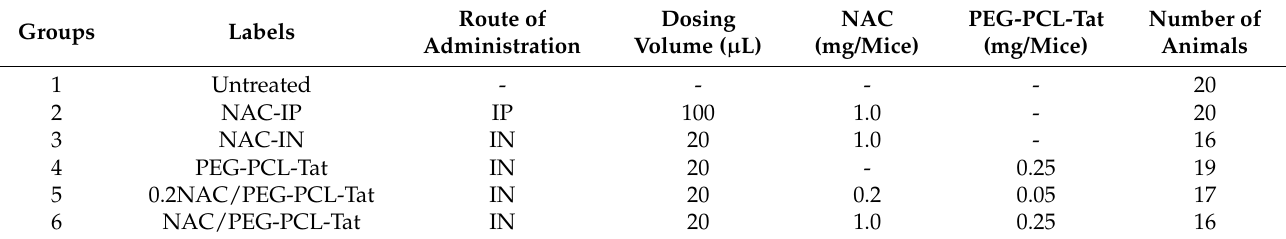
Table 1. Grouping and treatments of G93A